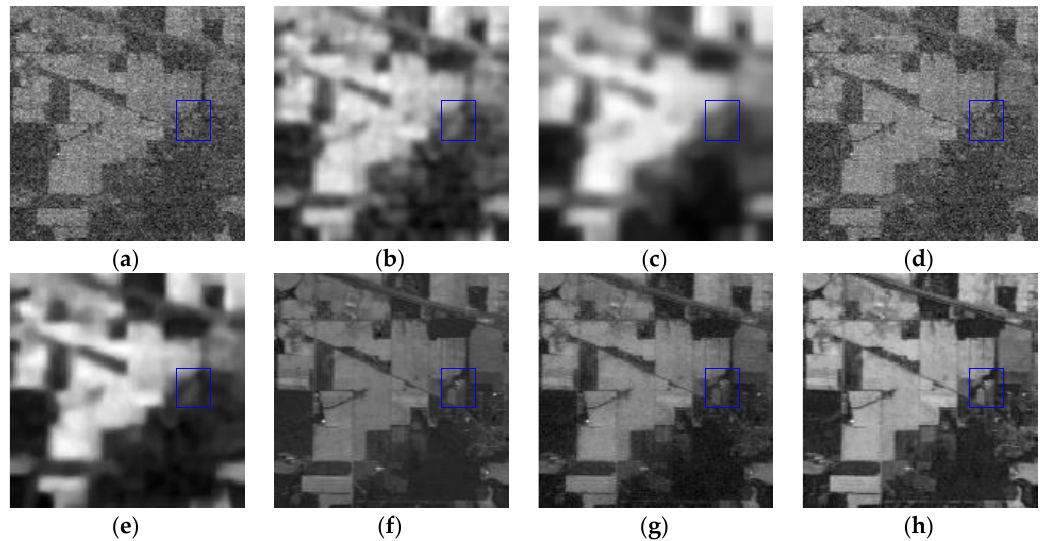
Figure 18. Restored results in Indian Pines image: ( a ) Original band 164; ( b ) KSVD; ( c ) BM3D;